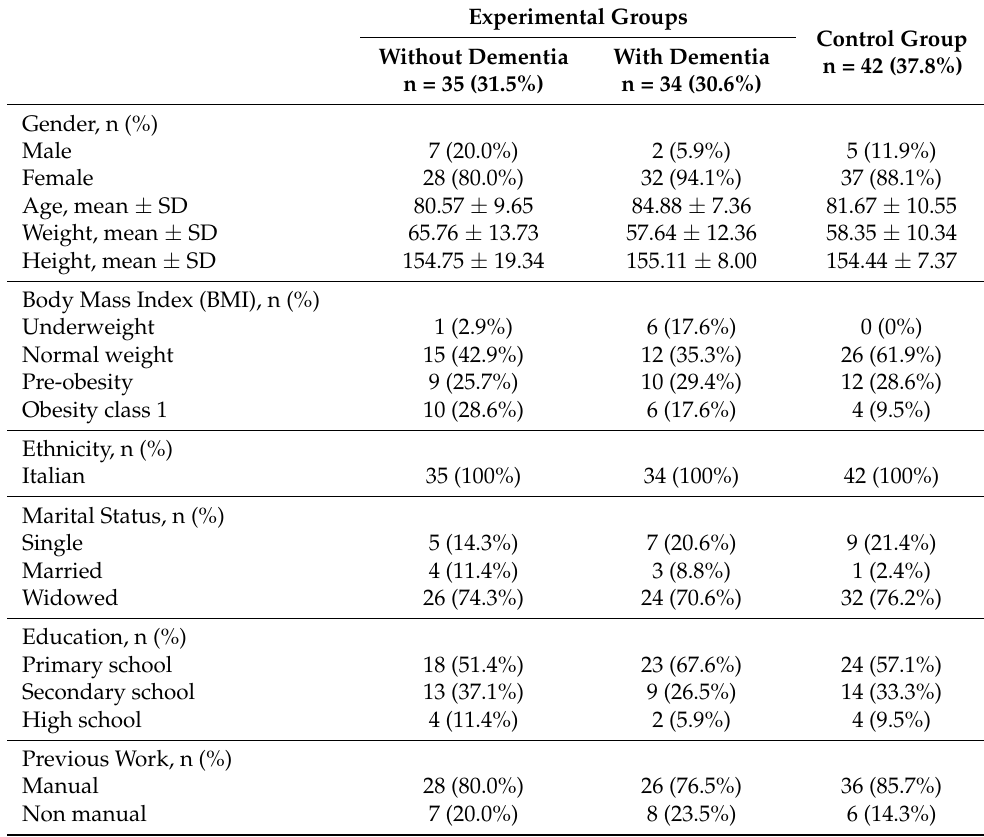
Table 1. Sample demographic characteristics by